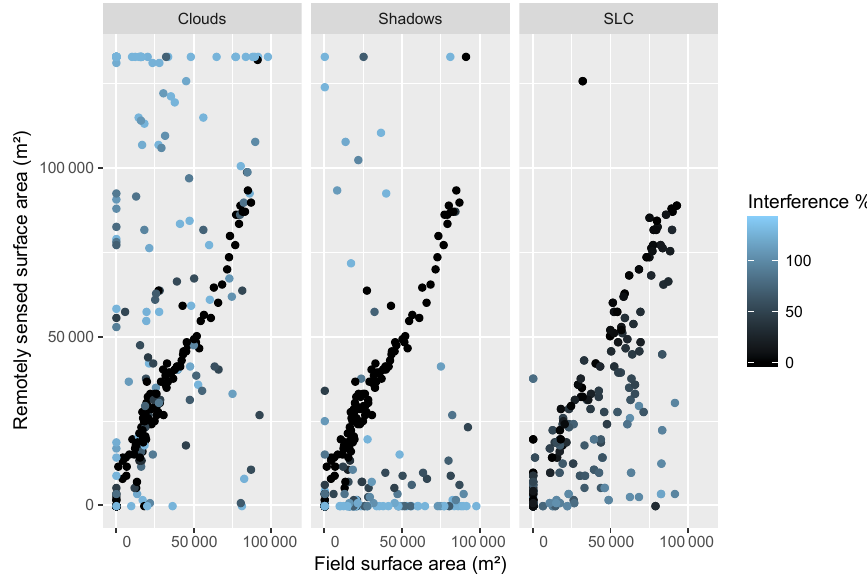
Figure 10. Errors due to interference from clouds, shadows, and SLC-off percentage across the Gouazine lake cell.